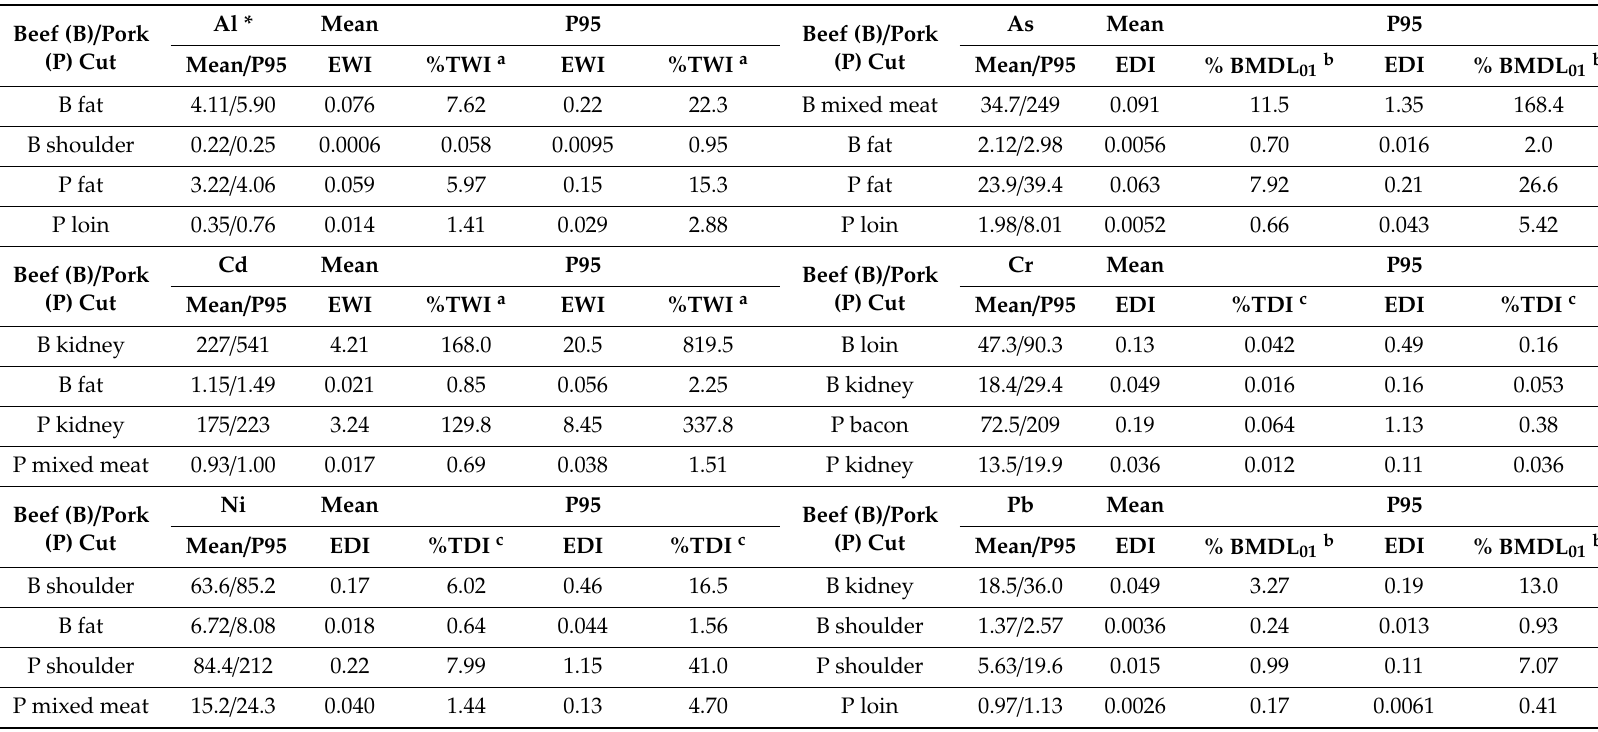
Table 5. Estimated daily and weekly intake (EDI, EWI) of toxic and trace elements and risk assessment for potential health exposure by the consumption of beef and pork